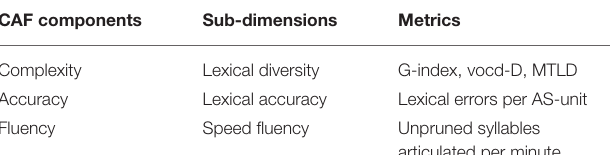
TABLE 1 | Metrics for measuring vocabulary learning performance.